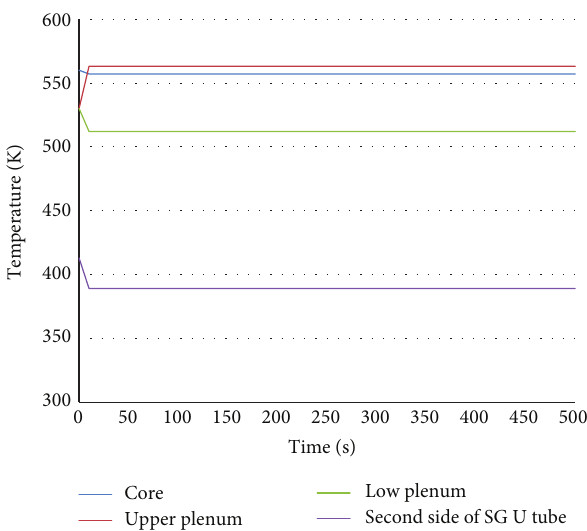
Table 4: Difference and error of calculation results between RELAP5 and